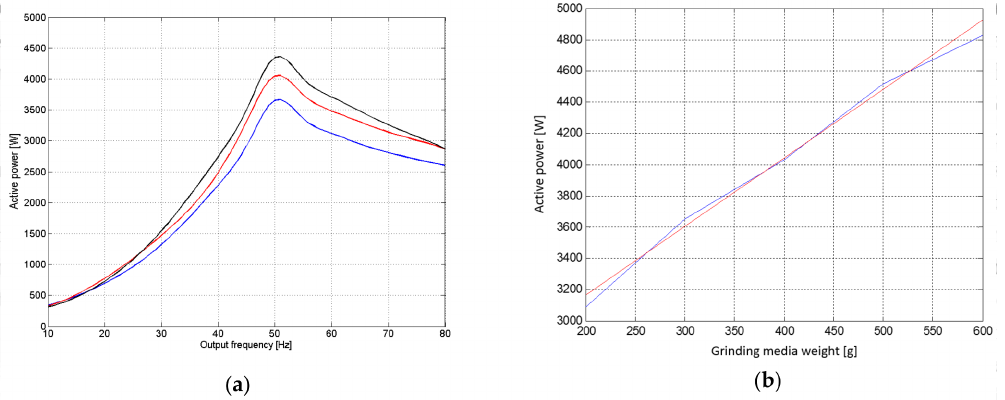
Figure 11. Active power of electromagnetic mill of 100 mm diameter: ( a ) grinding media mass 600 g—black line, 400 g—red line, 200 g—blue line; and, ( b ) frequency 50 Hz, measured active power and its linear